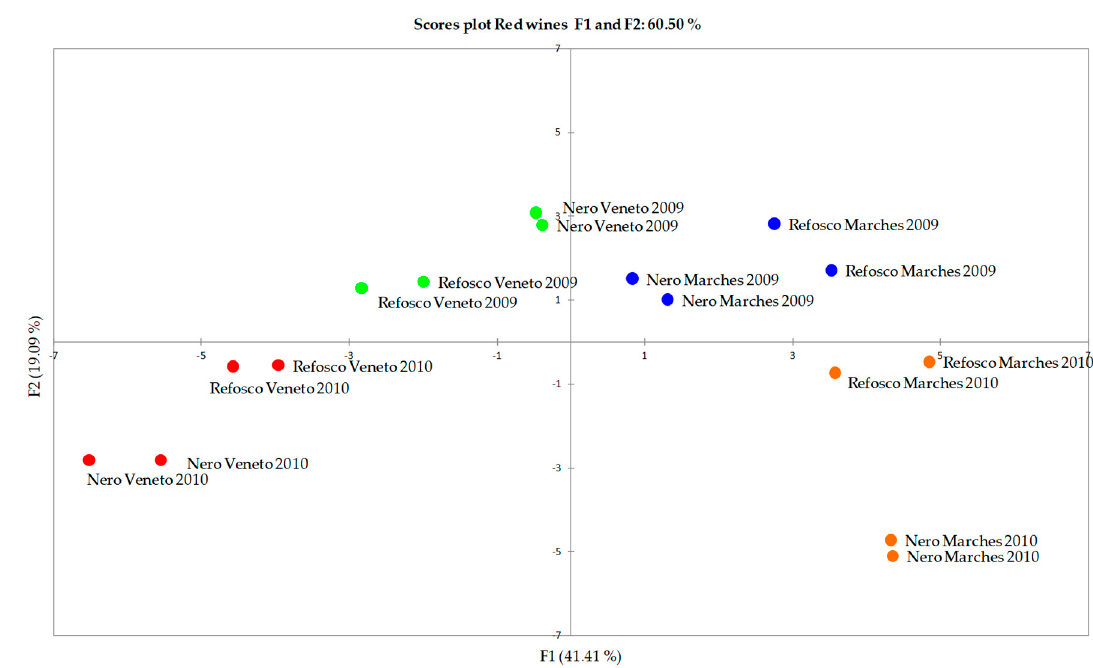
Figure 5. Score plot for red wines (Nero d’Avola and Refosco) in the two vintages (2009–2010).